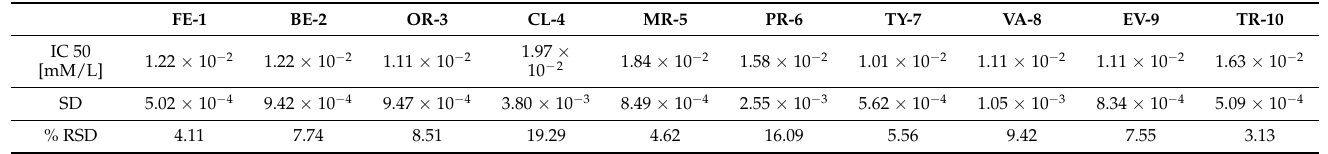
Table 6. Cytotoxic properties of the analyzed